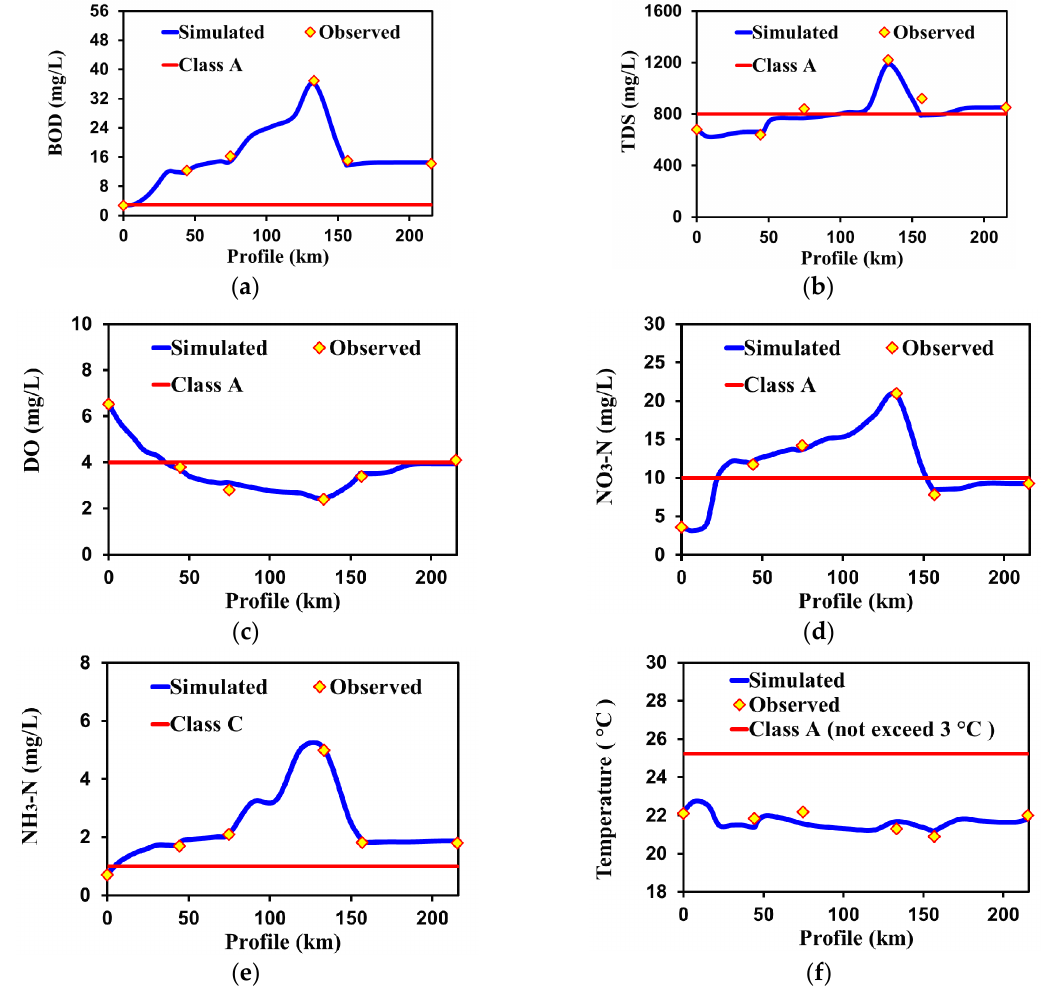
Figure 6. Model validation of water qualities along the Ravi River for data on 17–18 May, 2018 ( a ) BOD, ( b ) TDS, ( c ) DO, ( d ) NO 3 ‐ N, ( e ) NH 3 ‐ N, and ( f ) temperature.